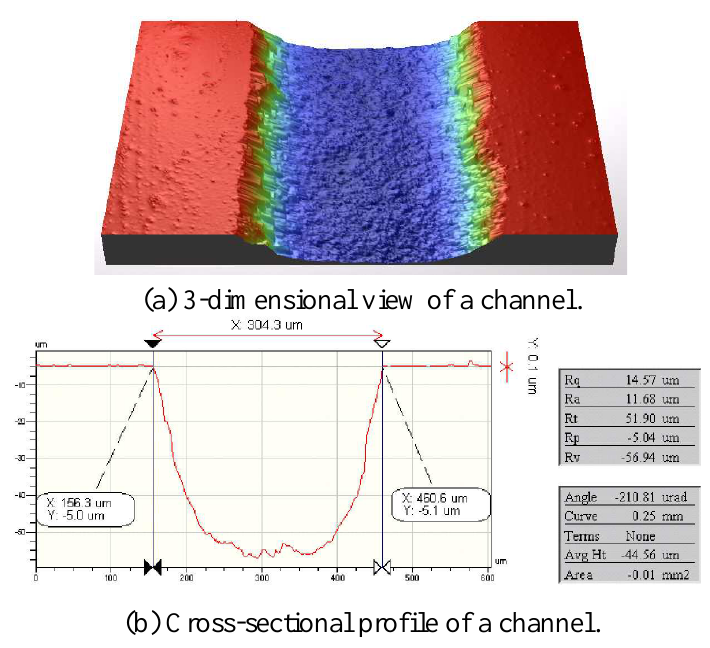
Figure 12. Profile analysis of a micro